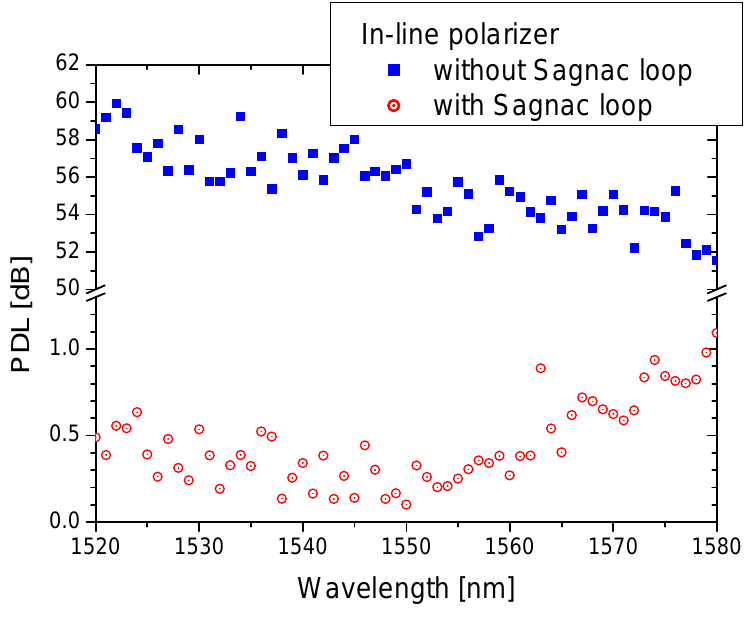
Figure 2. For each configuration of in-line polarizer without and with a Sagnac loop, the average PDL is measured to be 55.6 dB and 0.45 dB,